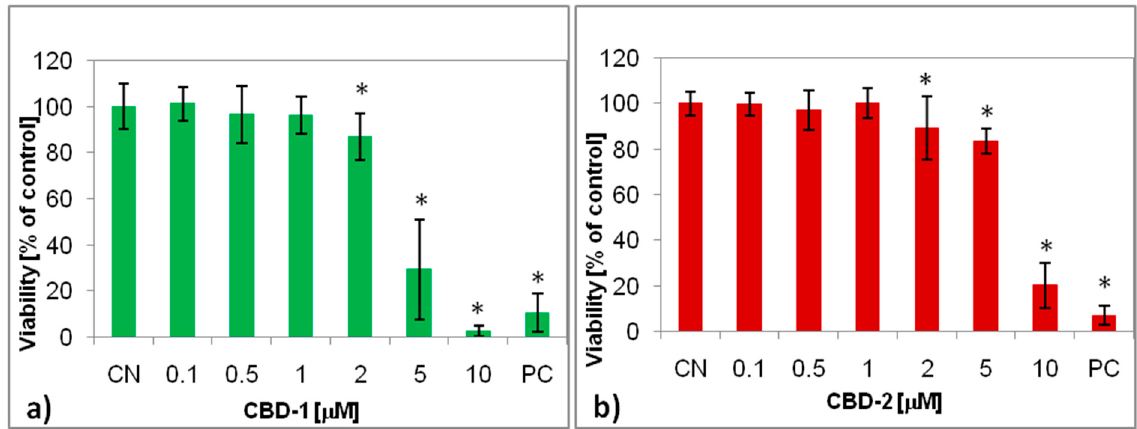
Figure 6. Protective effect of CBD-2 on siRNA in the presence of RNase A/T1 mix. ( a ) CBD-2 + Mcl-1, ( b ) CBD-2 + Bcl-2; 1, naked siRNA; 2, CBD-2; 3, siRNA + RNase; 4, siRNA + CBD-2 + RNase; 5, siRNA + CBD-2 + RNase + heparin; 6, siRNA + CBD-2.